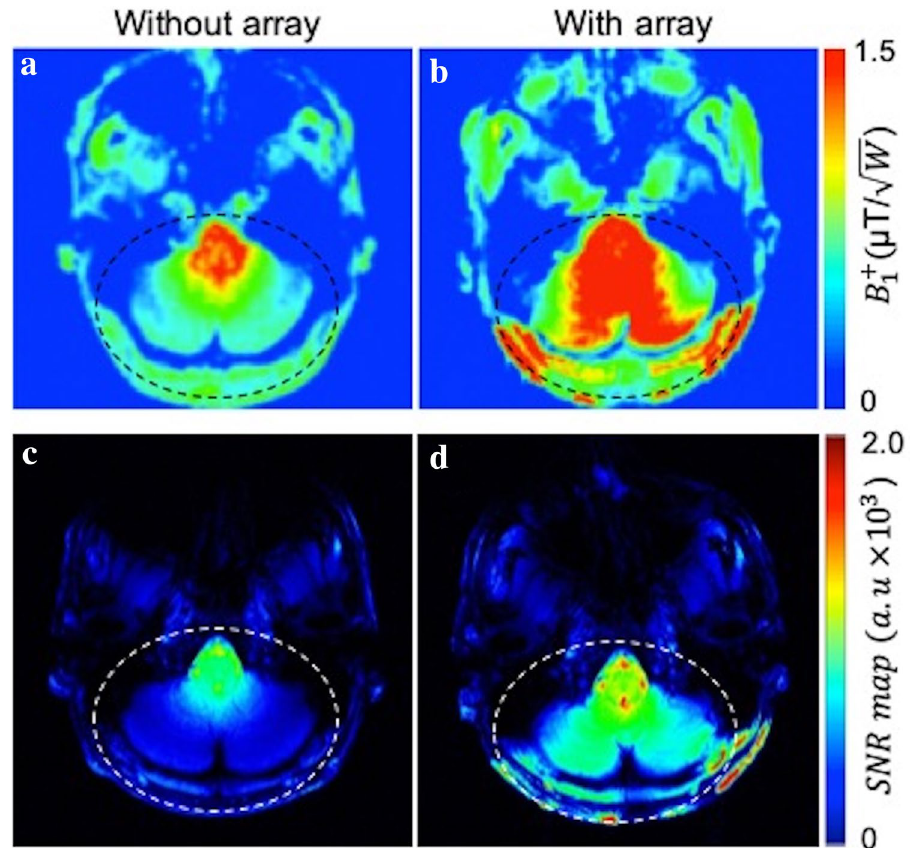
Figure 6. Experimental B + 1 maps without ( a ) and with ( b ) the array show an improvement with the RF array in the inferior regions of the brain. Average B + 1 enhancement of 1.8 0.2 was calculated across all subjects in the ± cerebellum and brainstem. Experimental SNR maps without ( c ) and with ( d ) the array for one subject show that placing pads of the array at the back of the neck improves SNR in the cerebellum, neck muscles, and